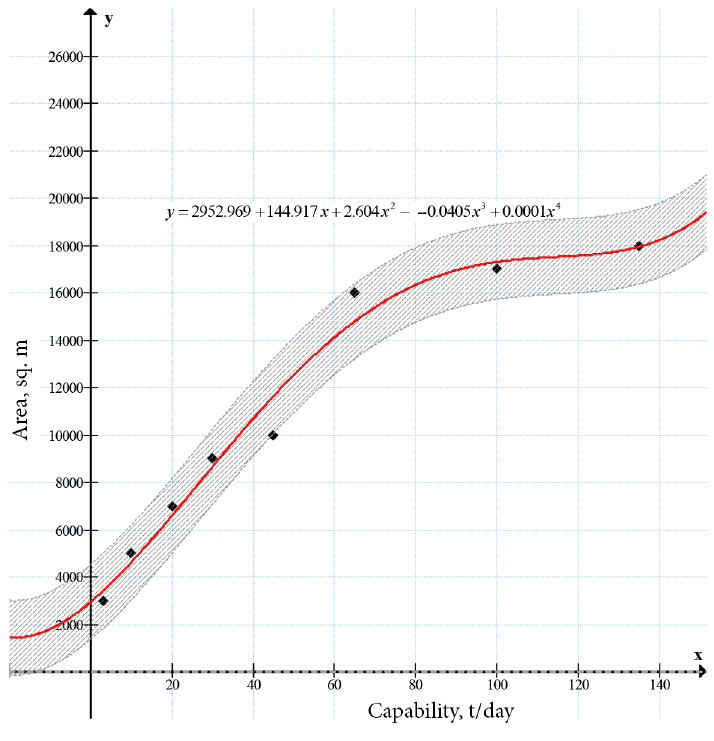
Figure 2. Graph of parabolic regression dependence